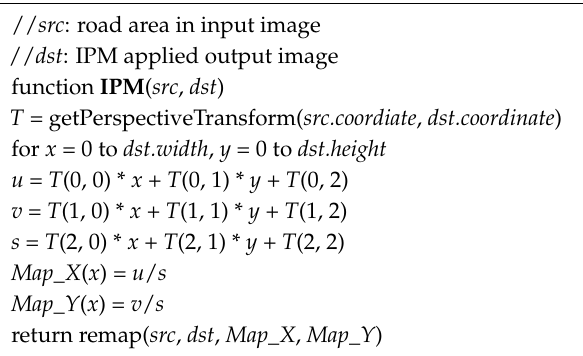
Algorithm 1: IPM Transformation